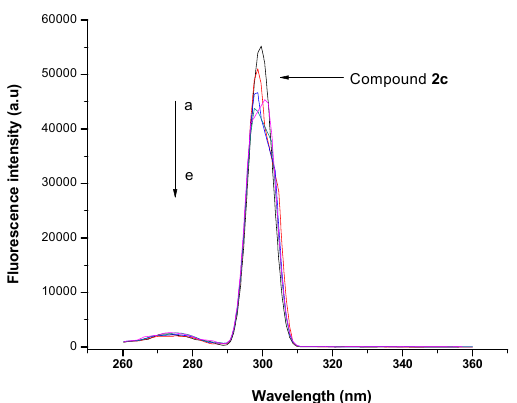
Figure 13. Emission spectra ( a – e ) the target material 2c (1 × 10 − 5 mol/L in 5 mM Tris, 50 mM NaCl, pH = 7.4 bu ff er with increasing GO concentration (from 0 to 6.68 × 10 − 5 mg/mL).